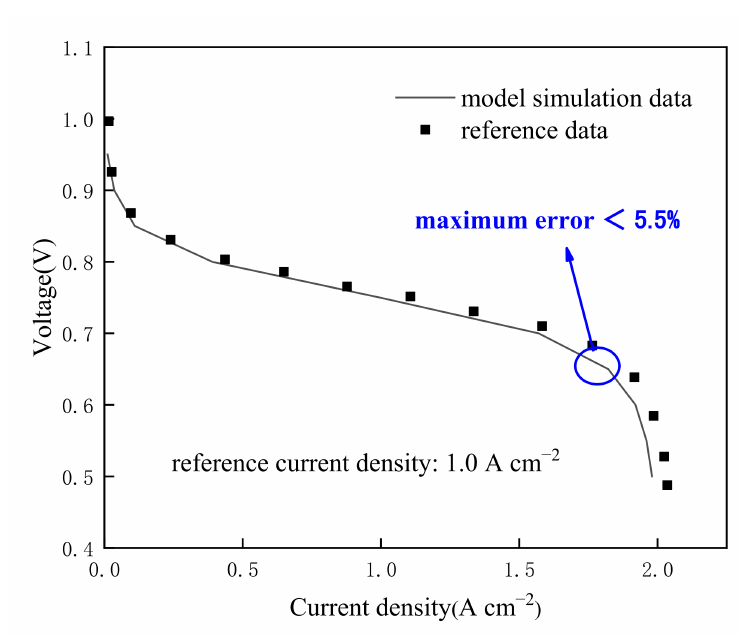
Figure 5. The model validation